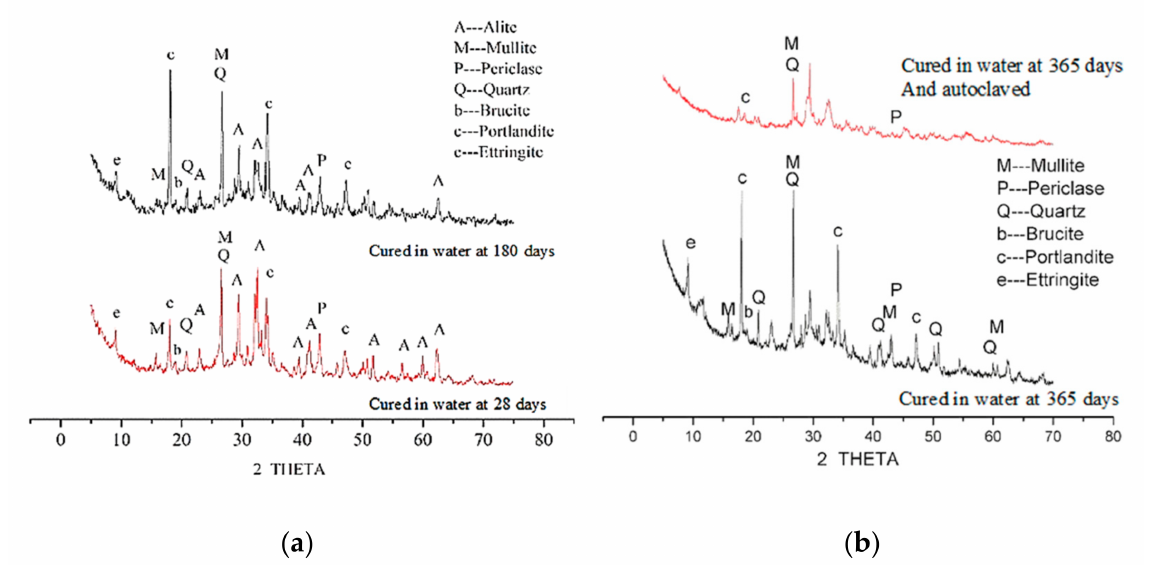
Figure 9. XRD patterns of hydration of cement paste mixed with 6% nano-MgO (28, 180, and 365 days). ( a ) cured in water at 28 days and 180 days and ( b ) cured in water at 365 days, and cured in water at 365 days and